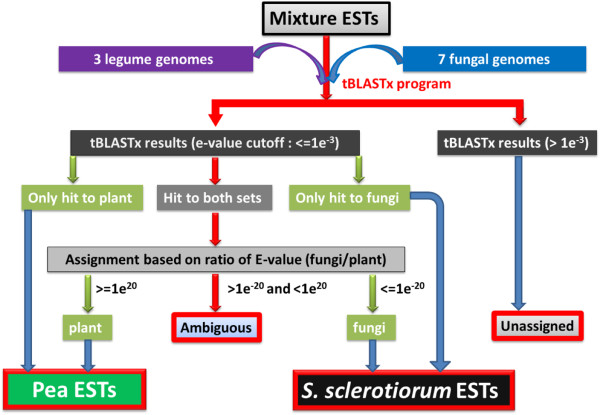
Flow diagram of host and pathogen EST parsing method for mixed transcriptomes from plant and fungi based on a modified tBLASTx method
.